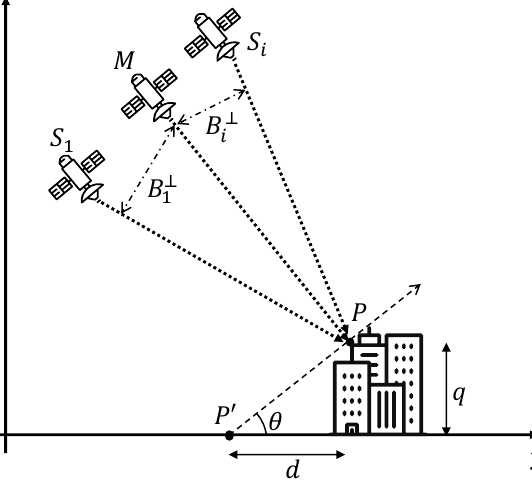
Figure 2: The acquisition geometry of a multipass SAR. The mas- ter acquisition is denoted with M while the B ⊥ i the normal base- line concerning the master and the i th slave. With the proposed procedure it is possible to retrieve the residual height q of the tar- get. By knowning then the local incidence angle θ it is possible to compensate the distance d (geocoding